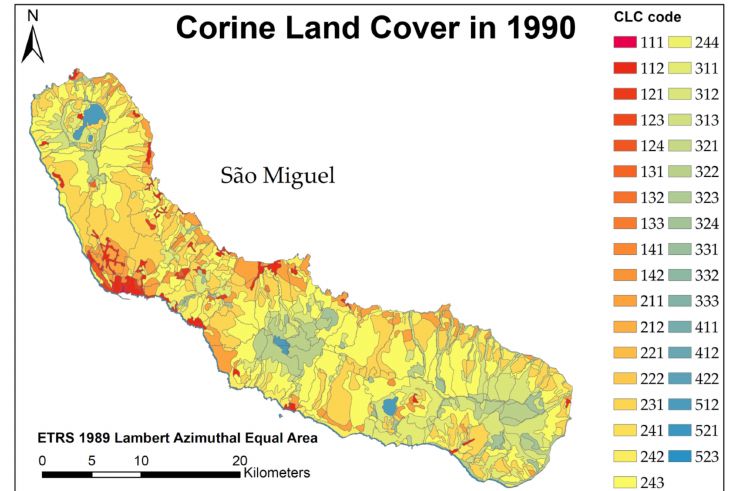
Figure 7. Thematic cartography regarding the land-use changes in the Azores Archipelago Eastern group in the year 1990.